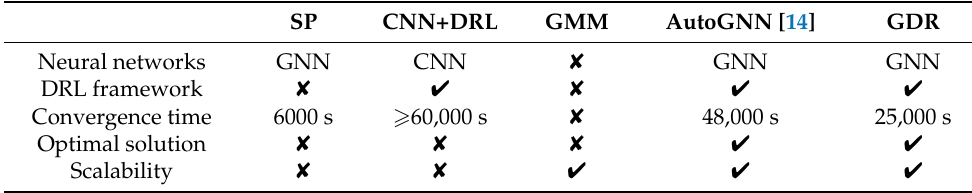
Table 2. A comparison of different algorithms.